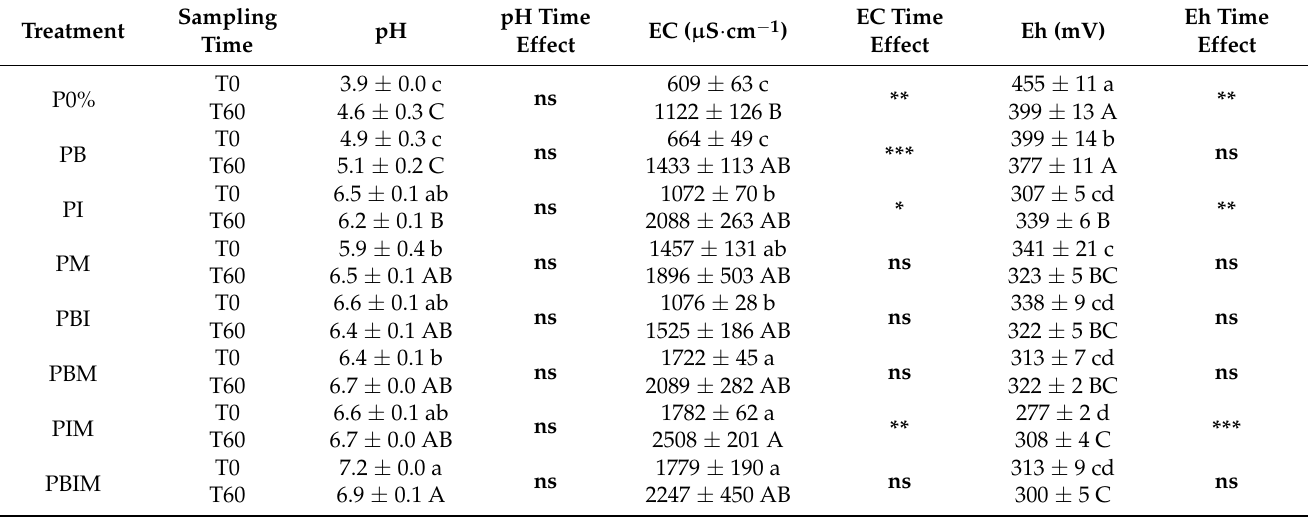
Table 3. Soil pore water (SPW) pH, electrical conductivity (EC) ( µ S · cm − 1 ) and redox potential (Eh) (mV) determined in the eight studied treatments. SPWs were sampled at the beginning of the experiment (T0) and after 60 days of Salix triandra plant growth (T60). The “treatment effect” for each sampling time is represented by lowercase letters for T0 and capital letters for T60 ( p < 0.05) ( n = 5 ± SE). In detail, for each sampling time, different letters indicate a significant difference among the treatments. The letters “a” and “A” are used for the highest value found. Different treatments with at least one letter in common show no significant difference. Thus, different treatments not having any letter in common are significantly different from each other. “Time effect” for each parameter and treatment is shown by: * ( p < 0.05), ** ( p < 0.01), *** ( p < 0.001), ns (non-significant). In detail, the “time effect” concerns any differences found between the two sampling